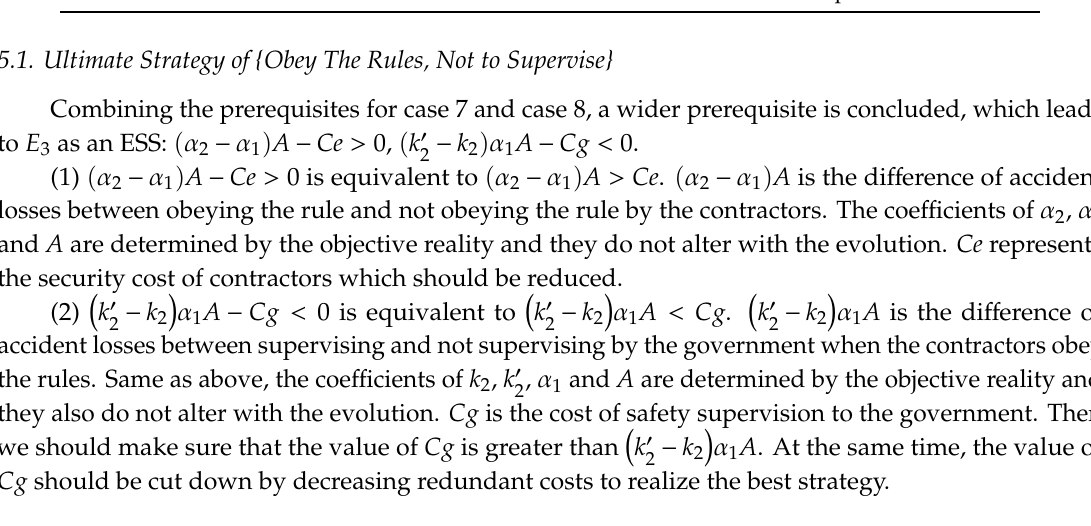
Figure 9. Circular process of evolutionary game between government and contractors in Case 12.